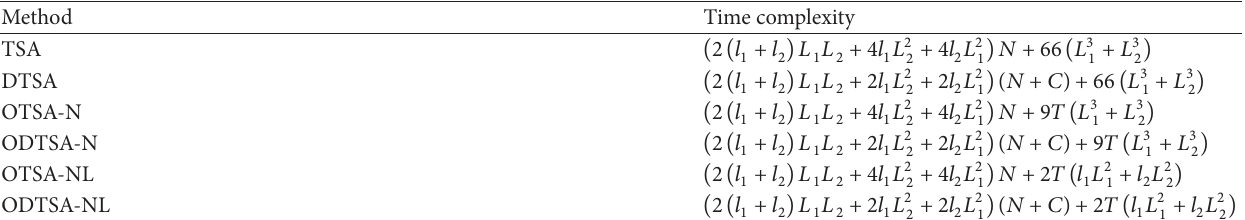
Algorithm 7: ODTSA. Table 1: Time complexity of TSA, DTSA, OTSA-N, ODTSA-N, OTSA-NL, and ODTSA-NL.